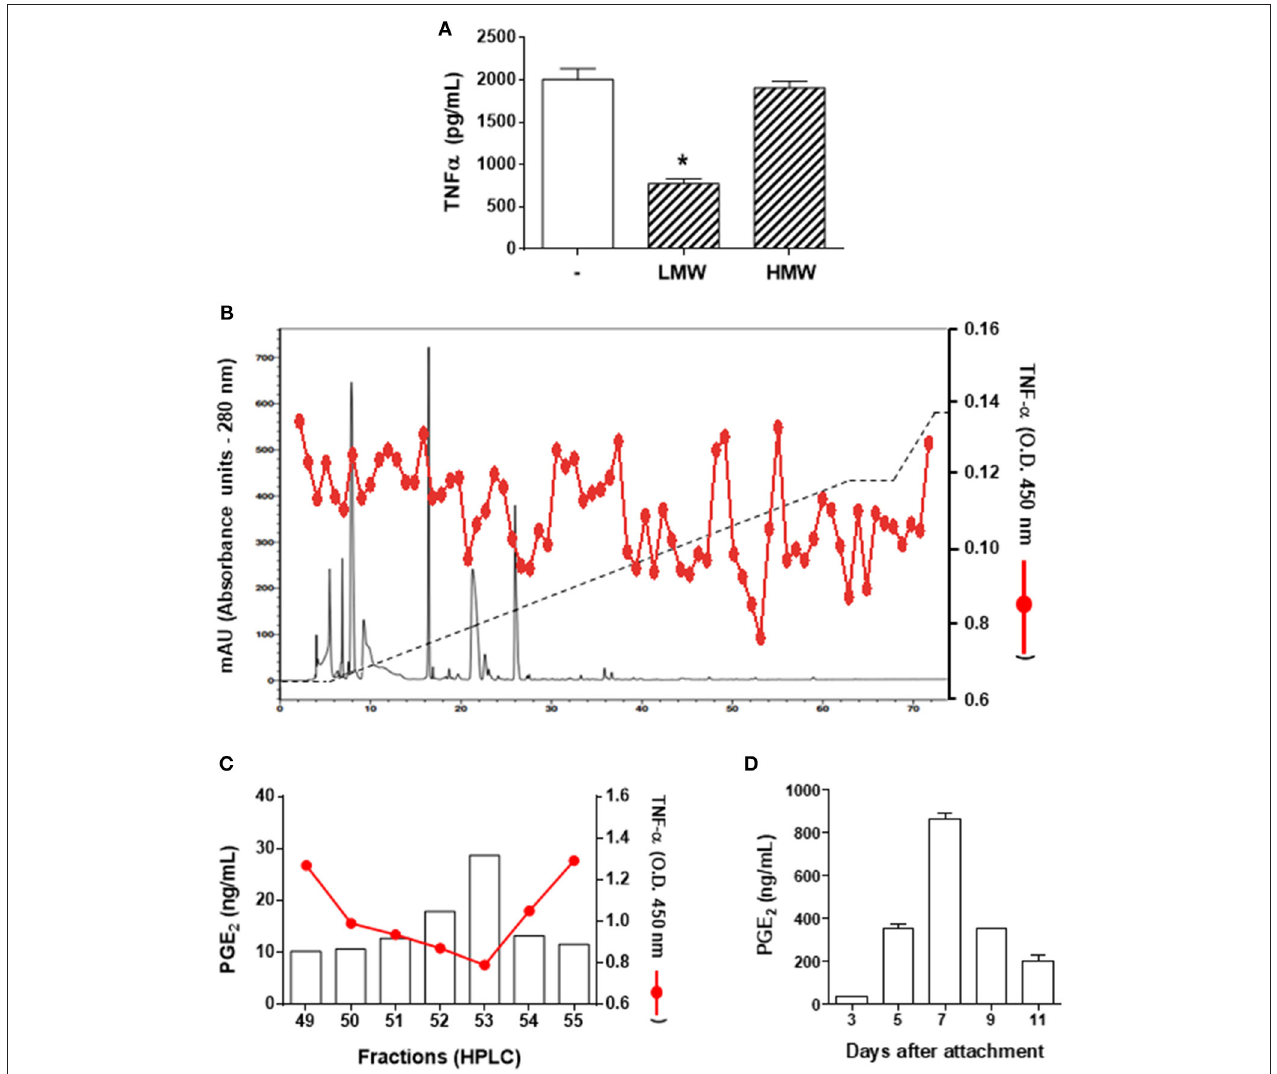
FIGURE 2 | PGE 2 is the DC modulatory molecule of A. sculptum saliva. Bone marrow cells from C3H/HePas mice were differentiated into DCs, seeded at 10 5 cells/well in 96-well plates and preincubated for 1h with medium only, with a low molecular weight (LMW) or with a high molecular weight (HMW) fractions of A. sculptum saliva collected by pilocarpine stimulation from female ticks fed on host for 7–9 days. Cells were stimulated with ultrapure LPS (200ng/mL) and after 6h, the TNF- α production was evaluated in culture supernatants by ELISA (A) . The LMW fraction was fractionated by UFLC (solid black line), eluted with a linear gradient of ACN (2–60% -dashed black line). Each fraction was tested for LPS-induced TNF- α production by DCs (solid red line) (B) . PGE 2 concentration was determined in the fractions presenting stronger inhibition of TNF- α (eluted between 49 to 55% of ACN) by ELISA (C) . PGE 2 concentration was determined in A. sculptum saliva collected by pilocarpine stimulation from female ticks fed on host for 3, 5, 7, 9, and 11 days (D) . * p ≤ 0.05 vs. “LPS without fractions”